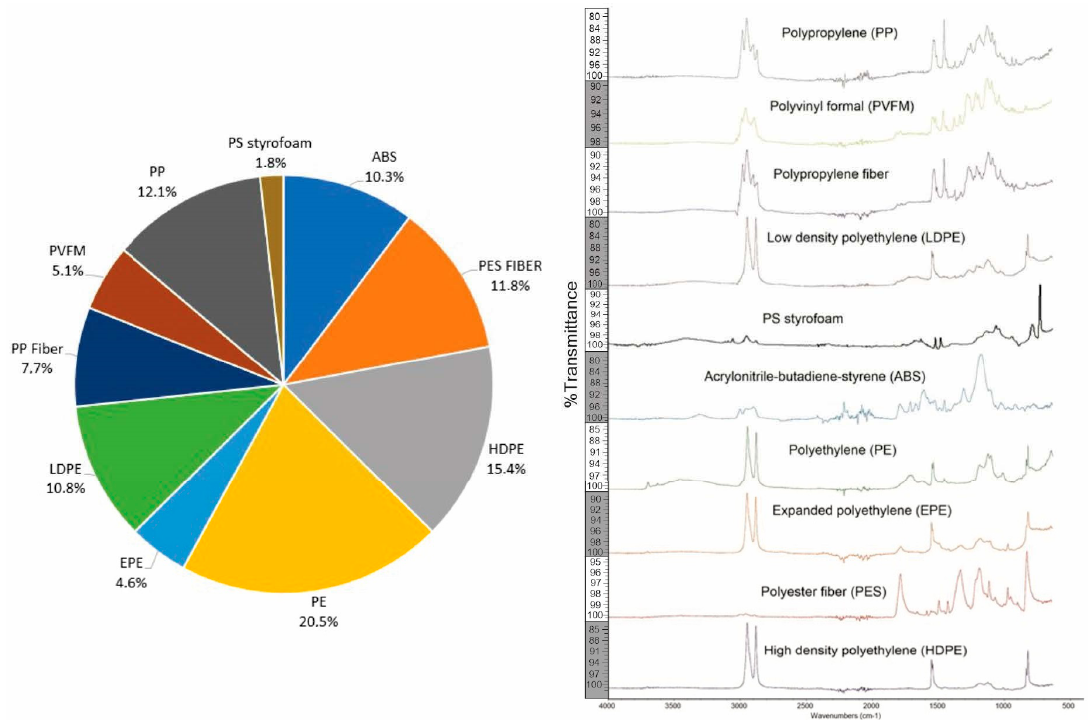
Figure 5. Types and number of polymers found in the studied area.